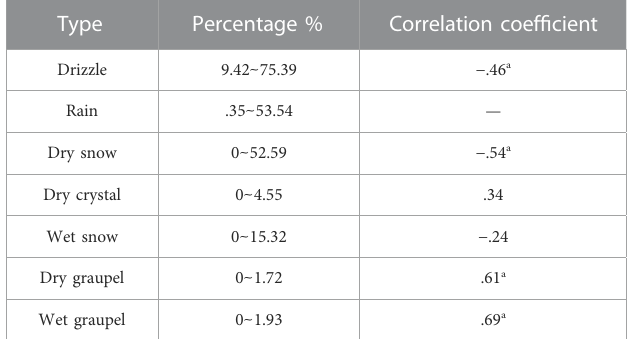
TABLE 2 The relative content of each hydrometeor type in Region 1 and its correlation with rain particles.